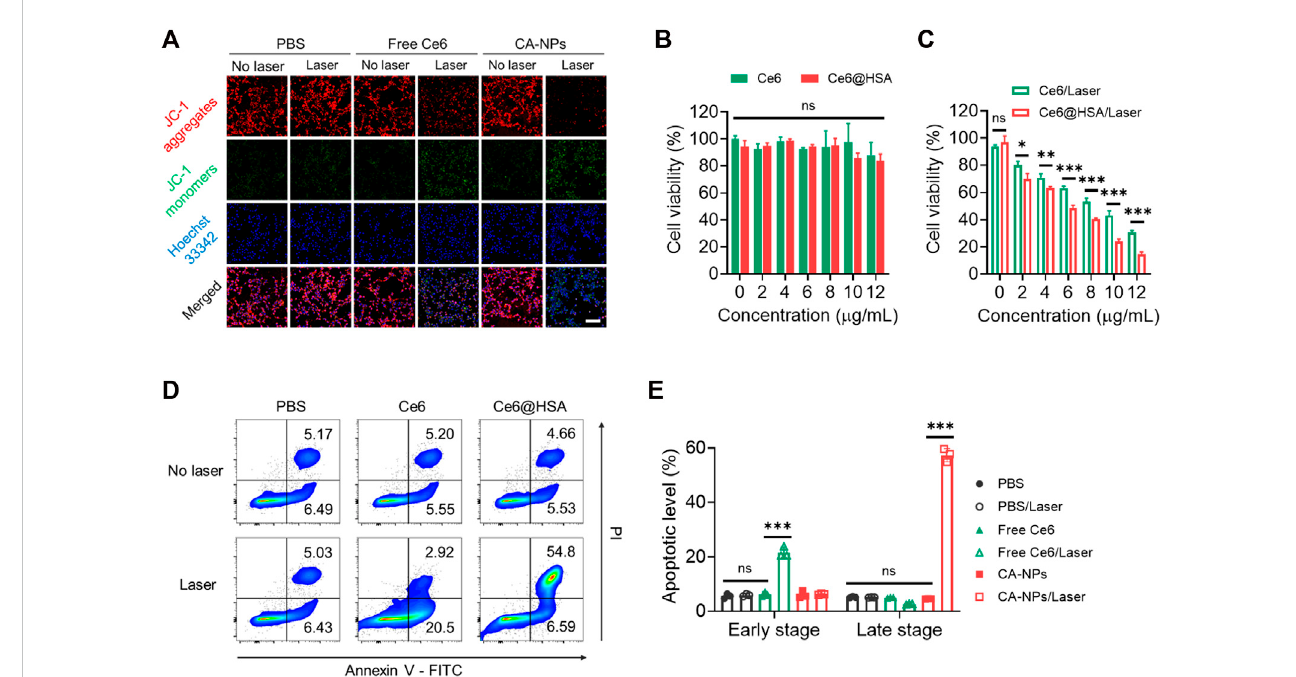
FIGURE 3 Cytotoxicityandtumor-killingmechanismofCA-NPs. (A) MitochondrialmembranepotentialofMB49cellstreatedwithPBS,freeCe6andCA-NPsatthe dose of 5 μ g/ml Ce6 detected by JC-1 assay. Scale bar: 100 μ m. (B,C) Cell viability of MB49 cells treated with free Ce6, CA-NPs under 660 nm irradiation or not(0.15 W/cm 2 ,5 min). (D,E) FlowcytometricmeasurementoftheapoptoticpercentagesofMB49cellsafter24 hincubationwithPBS,freeCe6andCA-NPs under irradiation or not. (n = 3; ns: no signi fi cance, * p < 0.05, ** p < 0.01, *** p < 0.001).